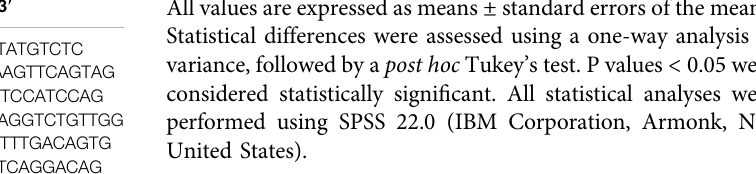
TABLE 3 | Primers used in the cellular